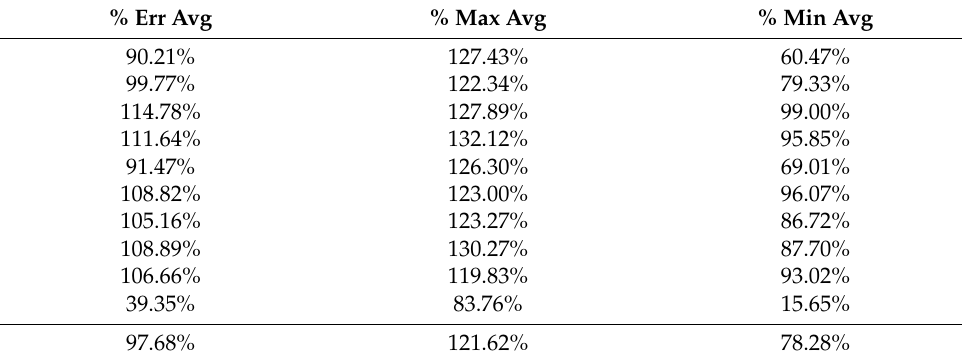
Table A182. Set 3, trials 11–20 data (all 0.5 PR